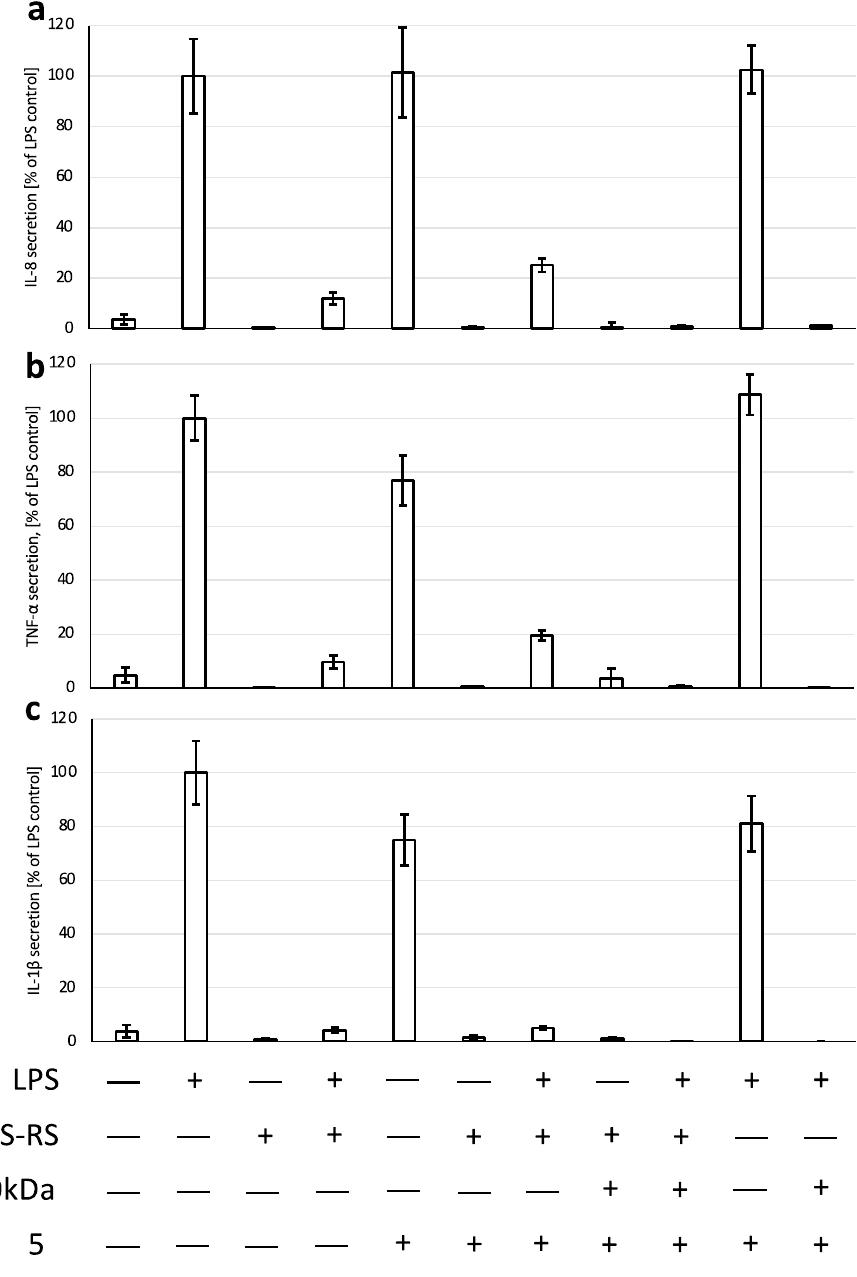
Figure 4. Influence of competitive TLR4 antagonist—LPS-RS (10 μg/mL) on secretion of IL-8 ( a ), TNF-α ( b ), IL-1β ( c ) following neutrophil stimulation by extract 5 (50 μg/mL) and/or LPS (100 ng/mL). Data